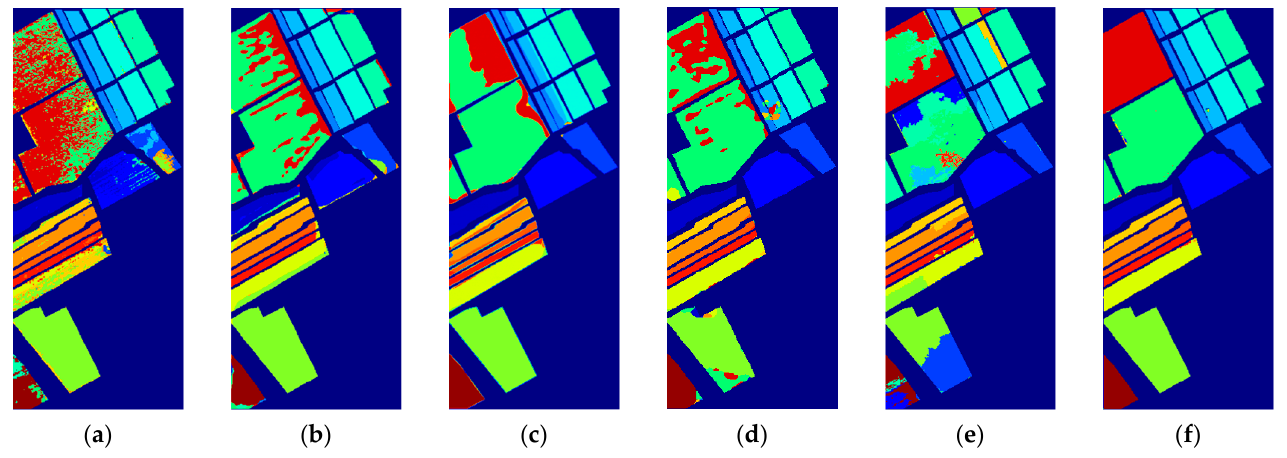
Figure 11. The predicted label images of different methods on SA: ( a ) SVM, ( b ) 3DCNN, ( c ) SSRN, ( d ) HybridSN, ( e ) Super-PCA, and ( f ) TBN-MERS.